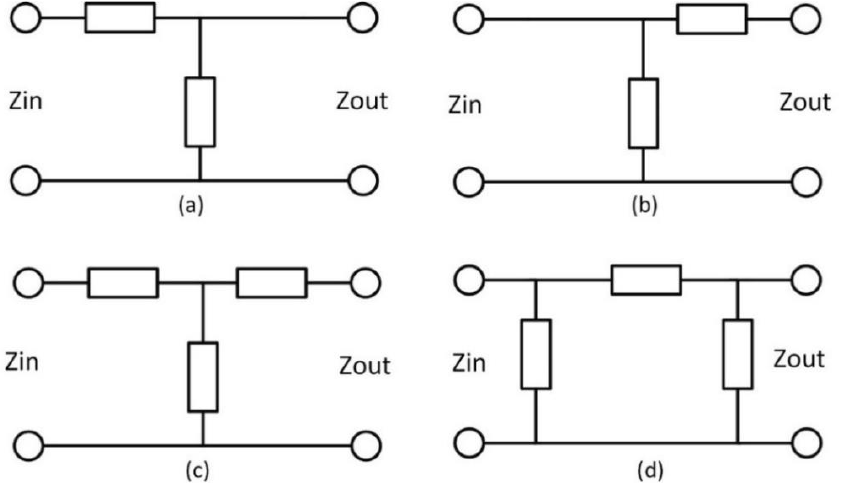
Figure 4. Different types of impedance matching networks with distributed elements: ( a ) L-network, ( b ) Reversed L-network, ( c ) T-network, ( d ) π -network [1].